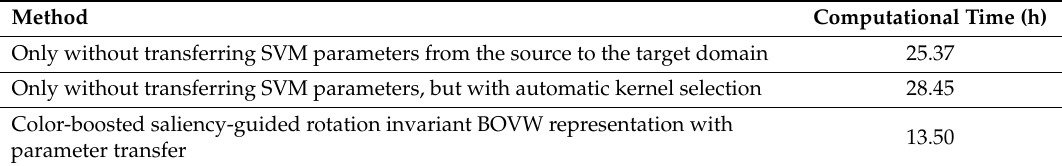
Table 4. The superiority of the color-boosted saliency-guided rotation invariant BOVW representation with parameter transfer method in reducing the computational time in the WHU-RS dataset compared with state-of-the-art